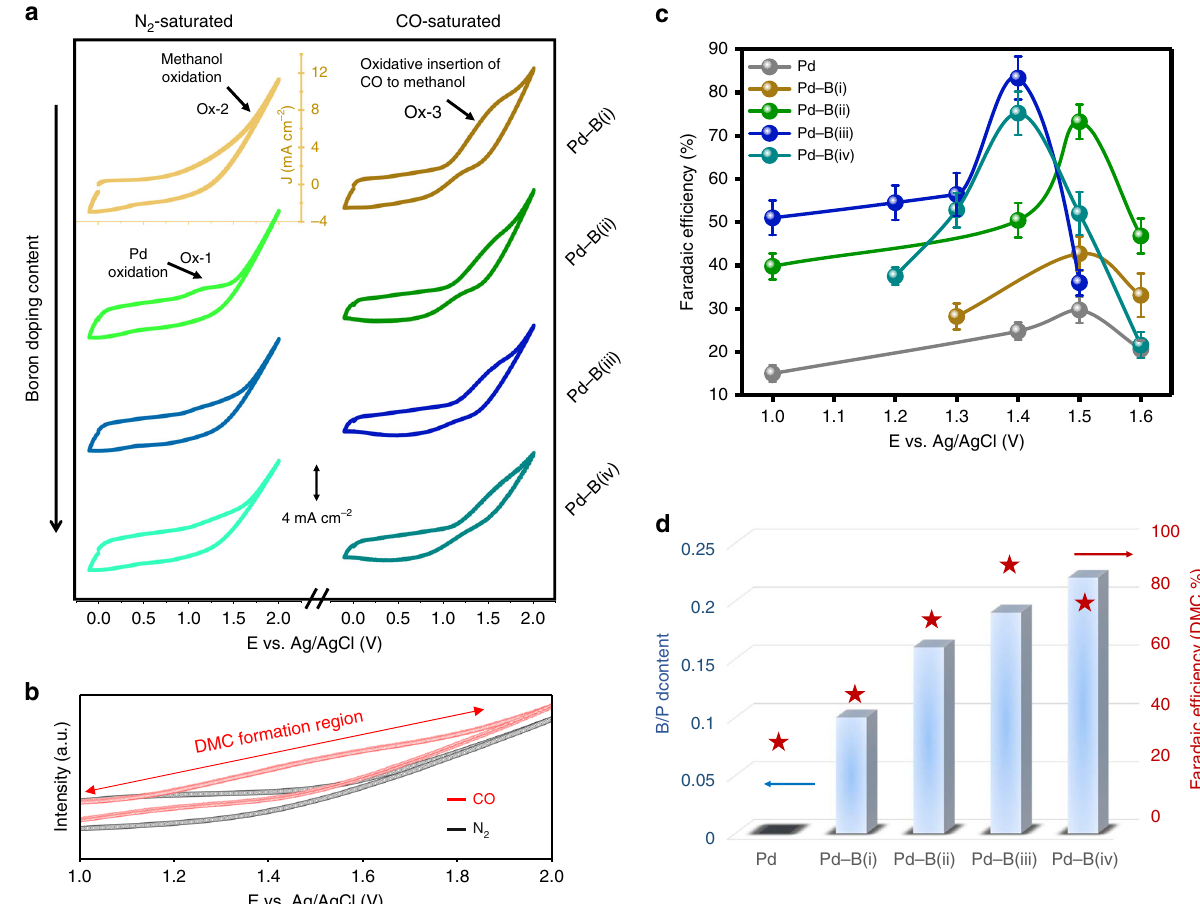
Fig. 4 Effects of boron doping in palladium on the DMC electroproduction. a Cyclic voltammograms on the Pd – B electrodes, 0.1 M NaClO 4 /methanol electrolytes; scan rate 50 mV S − 1 . Left: N 2 -saturated; right: CO-saturated. b ampli fi ed CV, highlighting DMC formation region. c DMC Faradaic ef fi ciencies on the catalysts under different applied potentials show the Pd – B (iii) sample has the best selectivity. d The effect of B doping content in Pd on DMC selectivity. Error bars correspond to the standard deviation of three or more